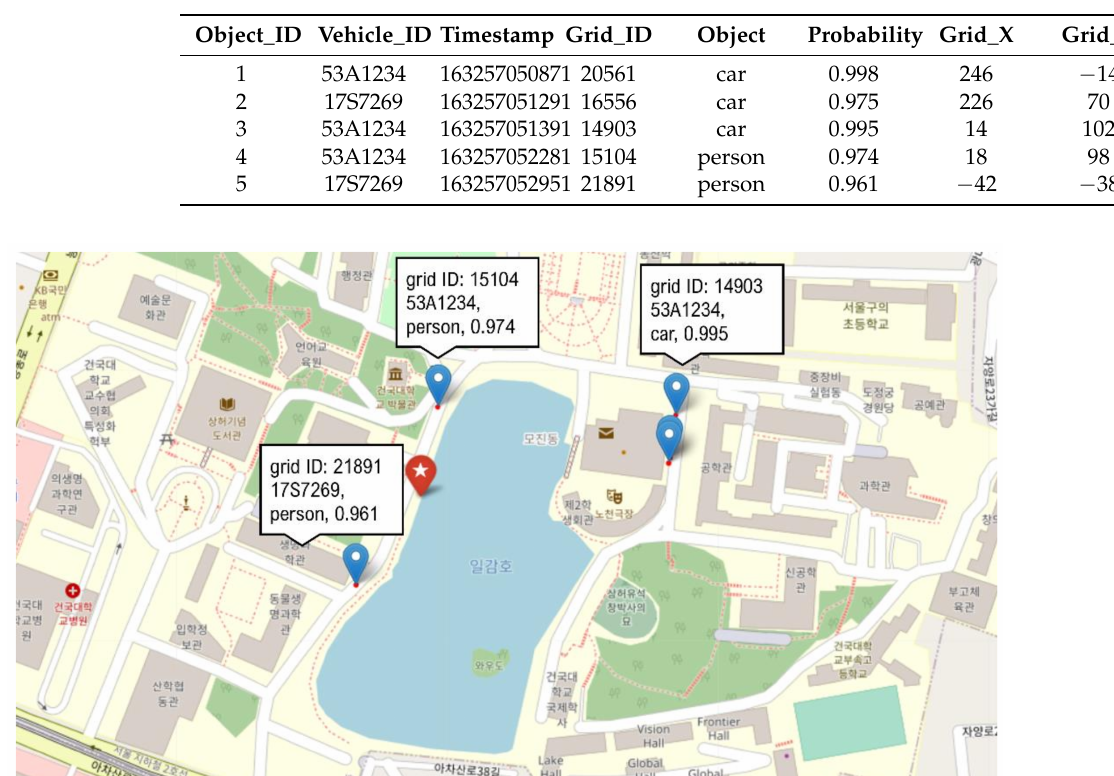
Table 1. Example of a database table stored in AWS cloud.